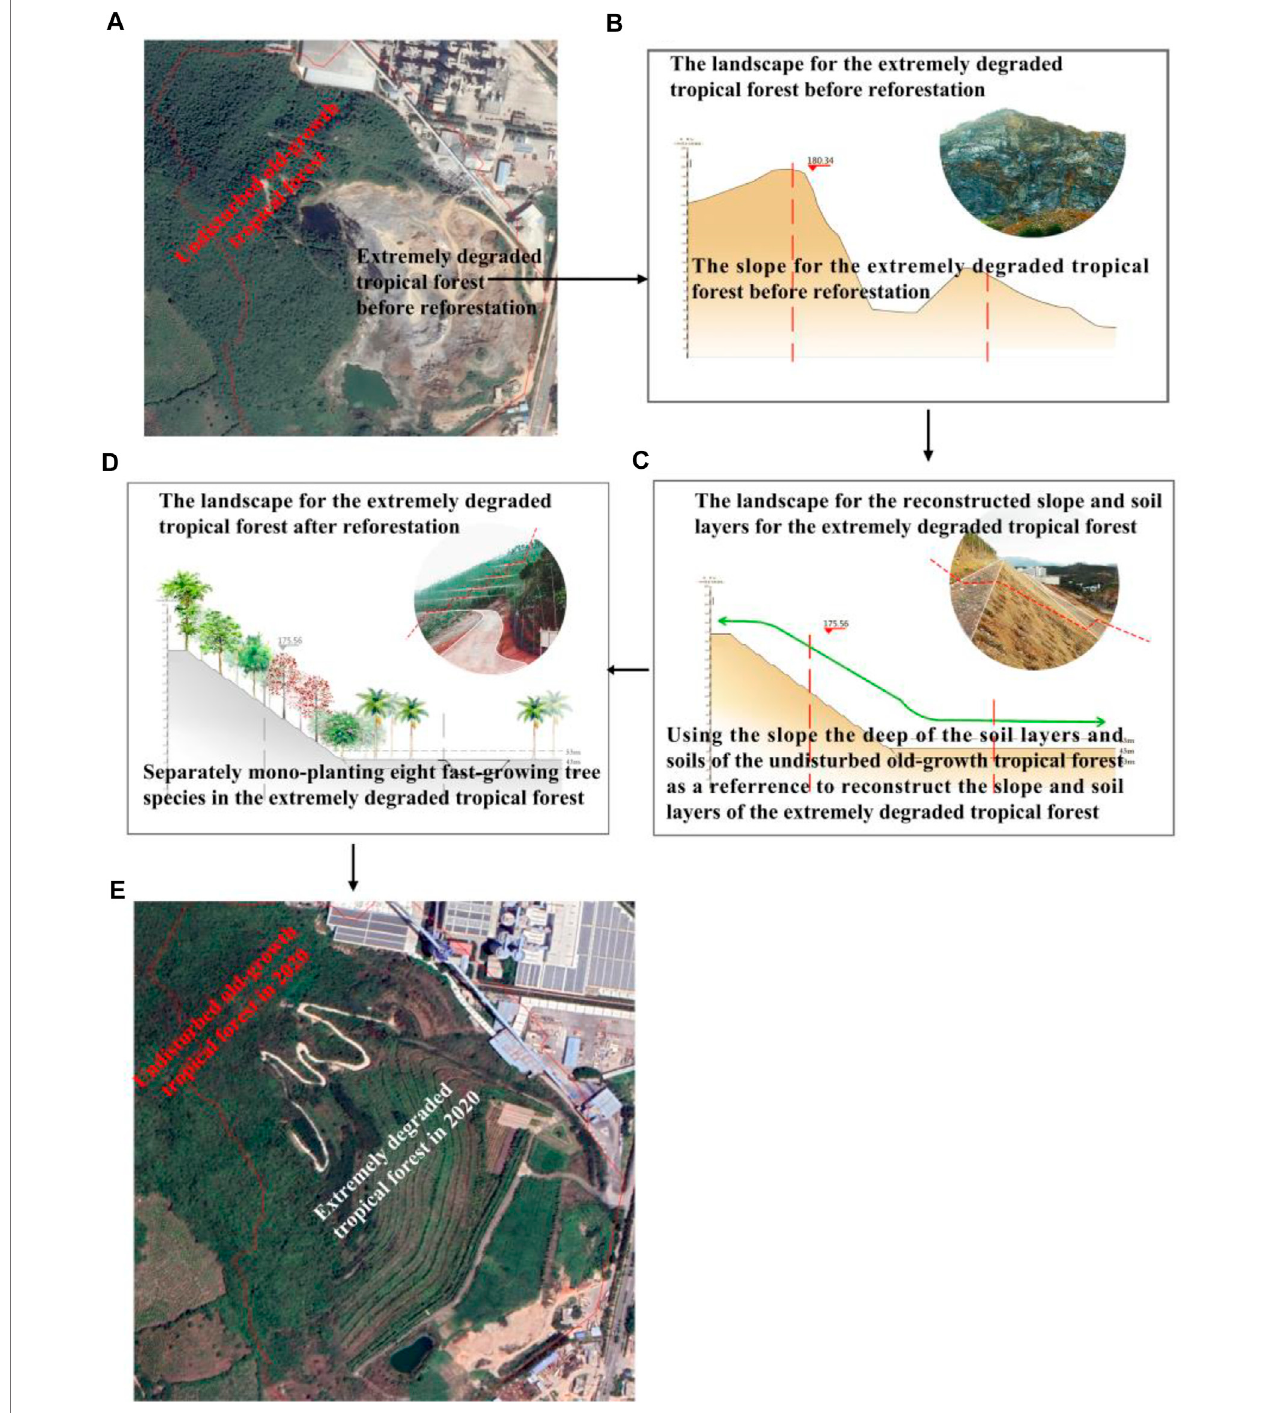
FIGURE 2 | The surrounding landscape and detailed procedures regarding the reforestation project in the 0.2 km 2 extremely degraded tropical rain forest in Baopoling mountain (BPL). (A) BPL and the surrounding landscape including the 0.2 km 2 area of extremely degraded tropical rain forest and the adjacent undisturbed old-growthtropicalrainforests. (B) theoriginallandscapeandslopeofthe0.2 km 2 extremelydegradedtropicalrainforest; (C) usingtheslope,thedeepofsoillayersasa reference to reconstructing slope and soil layers, and to re fi ll soils from the undisturbed old-growth tropical forests to form planting area in the extremely degraded tropicalrainforest; (D) separatelymono-plantingeightfast-growingtropicaltreespecies; (E) thelandscapeofundisturbedold-growthtropicalrainforestandthe0.2 km 2 extremely degraded tropical rain forest after reforestation efforts in 2020.